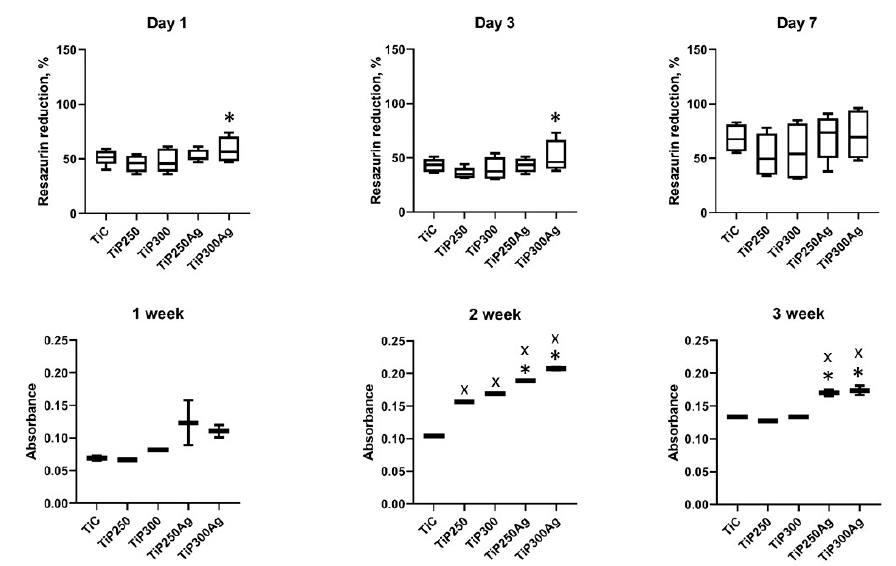
Figure 4. U2OS cell viability during 7 days of cocultivation over the Ti samples (upper row) and collagen production assay during 3 weeks of cell cultivation (bottom row): x significant difference with control group; * significant difference with Ag-free group.